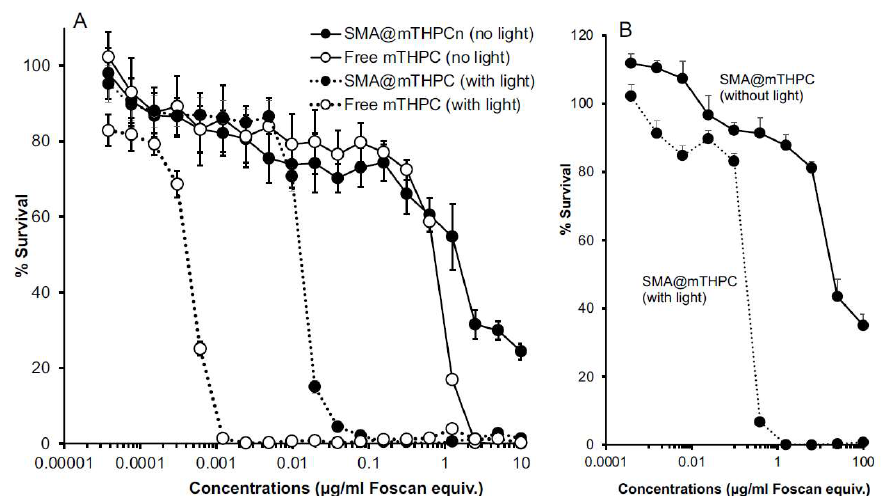
Figure 5. In vitro dark cytotoxicity and photocytotoxicity (PDT) of SMA@mTHPC in mouse colon cancer C26 cells ( A ) and African green monkey kidney cells (CCL-81) ( B ). Cells (5000/well) were seeded in a 96-well plate; after 24 h pre-incubation, different concentrations of SMA@mTHPC were added, and after further 24 h incubation, the viability of cells was measured by MTT assay. Photocytotoxicity was examined by irradiating the cells with light (blue light of 420 nm, 1 J/cm 2 ) at 24 h after addition of SMA@mTHPC. Data are mean ± SD, n = 6–8. See text for details.